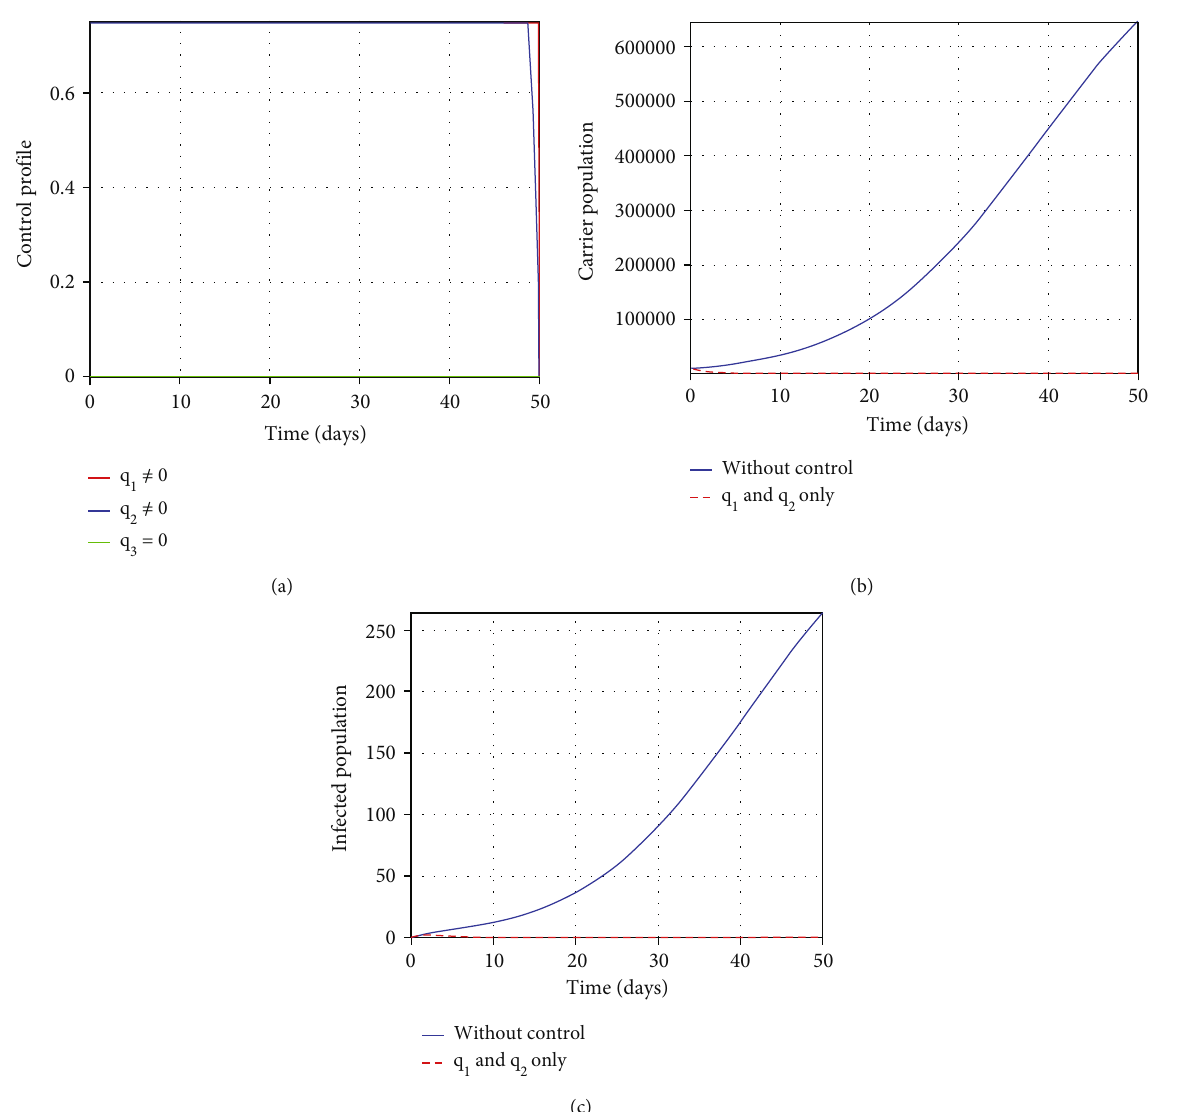
Figure 9: E ff ect of using both vaccination and treatment only. The control pro fi le in (a) shows that for e ff ective eradication of meningitis, vaccination must be applied to all individuals for 50 days while treatment is implemented for 48 days. The simulation result of the optimal control model shows the e ff ectiveness of these measures on (b) carriers and (c) infected individuals. In the graphs, the solid line denotes without the strategy while dotted line indicates implementation of the control